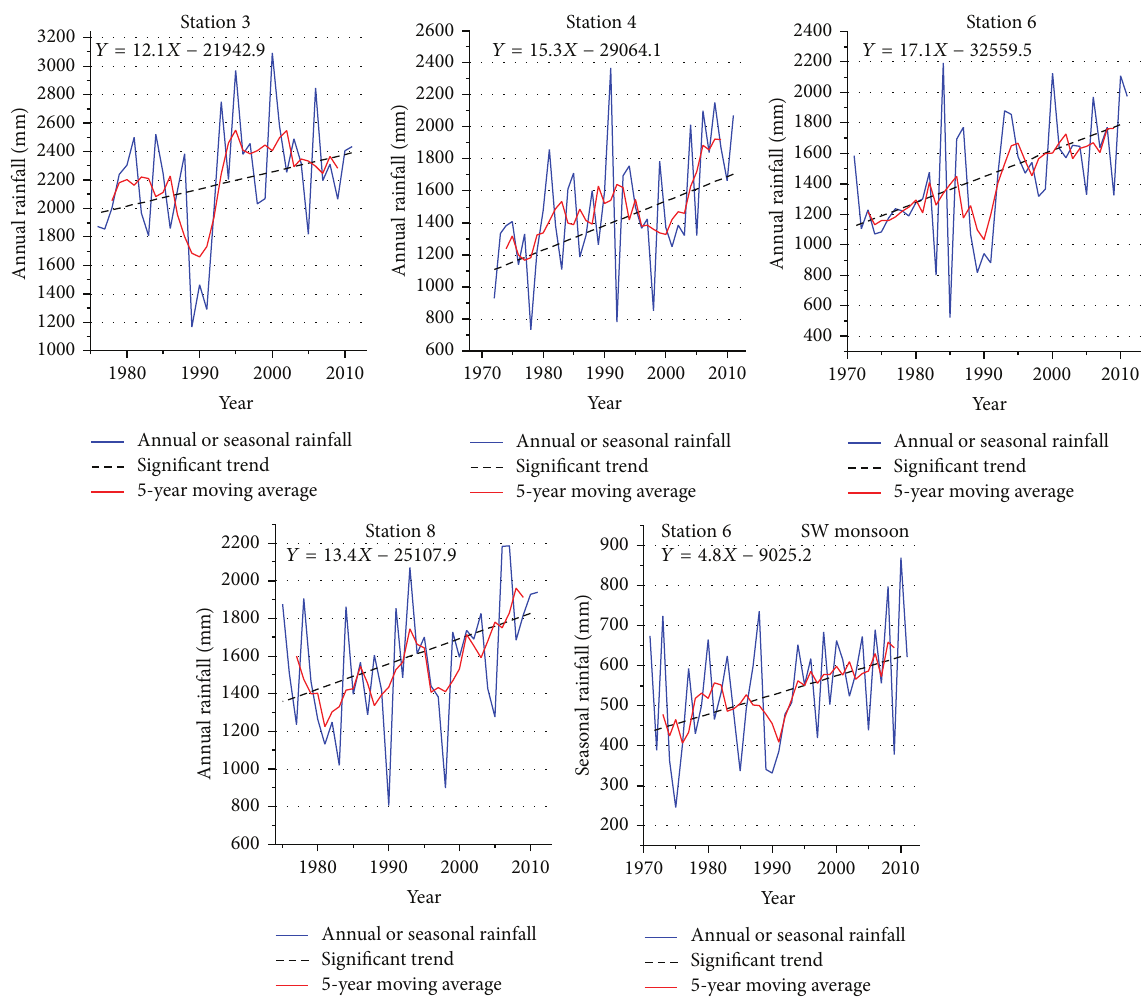
Figure 4: The plot of significant trends for annual and seasonal precipitation in the Langat River Basin at the 95% confidence